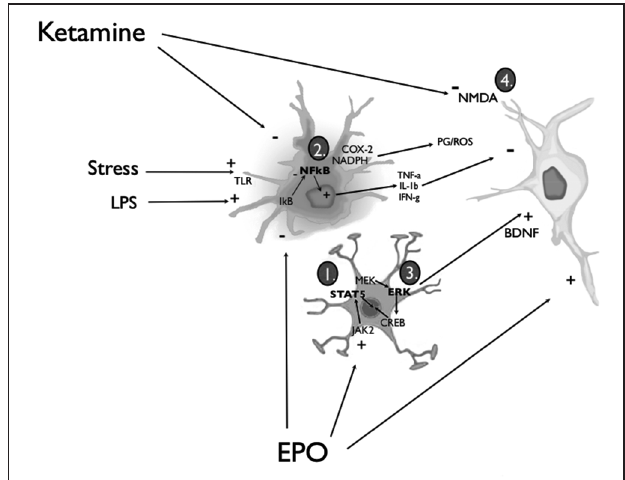
FIGURE 1 | Simplified diagram of the routes through which EPO or ketamine might affect glia and neurons to promote anti-depressant-like consequences . EPO can act upon astrocytes and neurons by (1) inducing the activation of JAK/STAT and PI3K/Akt signal transduction pathways or (3) promoting MAP kinase-MEK signaling, culminating in extracellular signal-regulated kinase (ERK) phosphorylation and the recruitment of cyclic adenosine monophosphate (cAMP) response element-binding protein (CREB). Engagement of these EPO/EPOR signaling pathways effectively biases the activity of pro- and anti-apoptotic cascades towards the latter, and increases the synthesis and release of BDNF from activated astrocytes and neurons. Signaling in neurons through its TrkB receptors (and the multiple associated signal transduction cascades), BDNF can promote a wide range of neuroplastic changes (e.g., enhanced synthesis of synaptic proteins and neurotrophins) that ultimately favor cell survival. In parallel, EPO can exert anti-inflammatory actions by (2) inhibiting the liberation of nuclear factor- κ B (NF- κ B) from its inhibitory binding partner, IkB, in microglial cells. Thus, pro-inflammatory cytokine release (e.g., tumor necrosis factor- α (TNF- α ), IL-1 β and IFN- γ ), as well as prostaglandin (PG) and reactive oxygen species (ROS) production via COX-2 and NADPH oxidase enzymes is inhibited. EPO can also cross the BBB to directly interact with neuronal receptors. Ketamine was similarly found to be capable of (2) attenuating the activation of microglia and astrocytes, as well as a variety of peripheral immune cells; the end result, once again, is an overall dampening of potentially neurodestructive pro-inflammatory responses. Nonetheless, a majority of the studies investigating the antidepressant-like action of ketamine have focused on the downstream molecular sequelae of the drug’s NMDA glutamate receptor antagonism (4). Considered to be of paramount importance in this regard are the up-regulation of BDNF (e.g., via inhibition of eEF2 kinase) and the activation of synaptogenic signaling pathways (i.e., mTOR/p70S6 kinase) (see text for additional